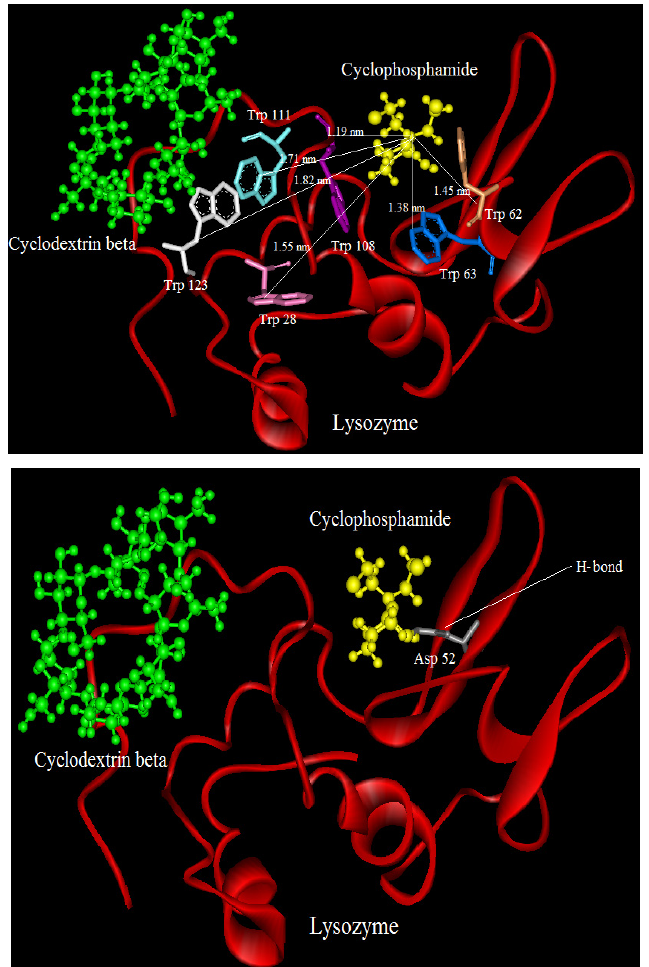
Figure 12. Distance between CYC and Trp residues in ternary system and in the presence of CD( β ); below: show the number and type of amino acids involved in the hydrogen binding between LYZ and CYC in presence o of CD ( β ).